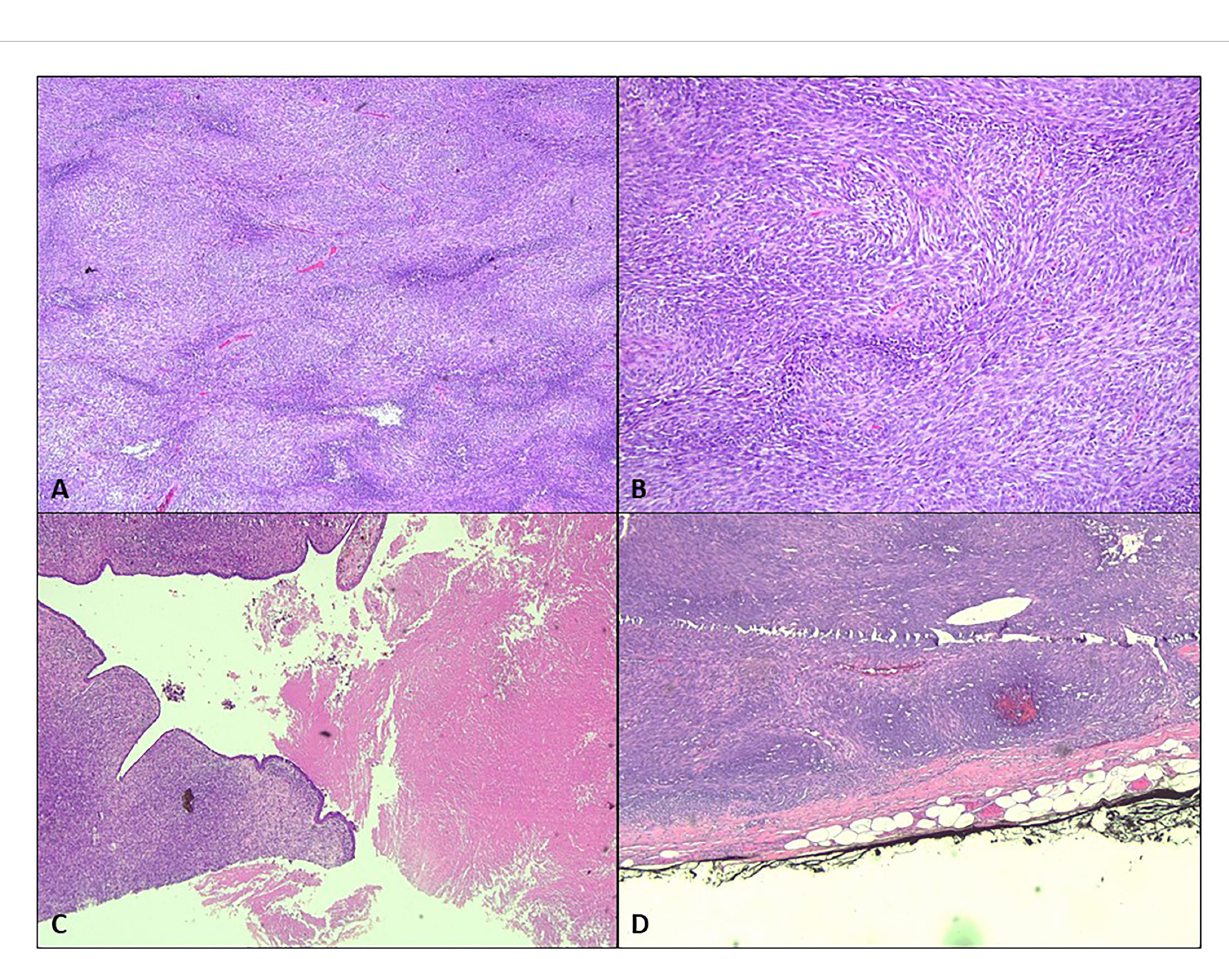
FIGURE 3 Microscopic analysis of the right breast. (A) The right breast tumor shows hypercellularity [hematoxylin – eosin (H&E) staining, ×4]. (B) The spindle- shaped cells are arranged in fascicles in a herringbone pattern (H&E, ×20). (C) Focal leaf-like pattern typical of phylloides tumor with adjacent necrosis (H&E, ×4). (D) The tumor is seen less than 1 mm from the inked deep margin (H&E,